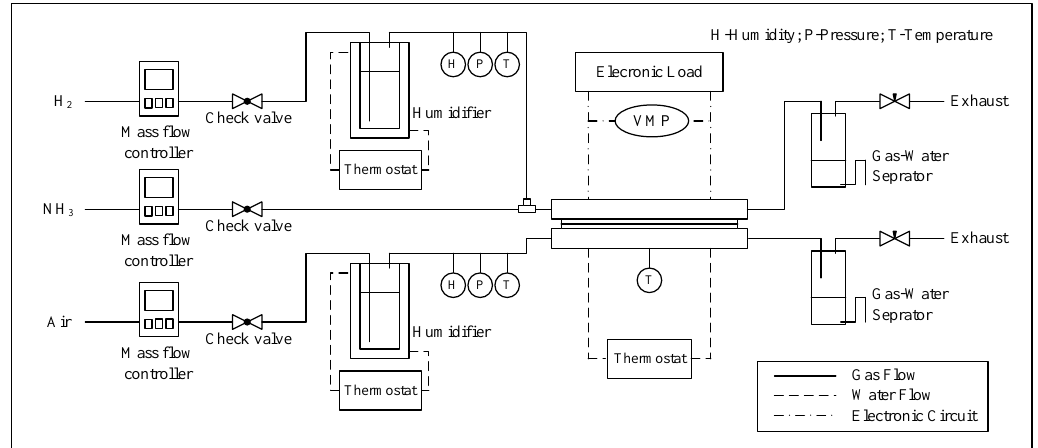
Figure 1. Schematic of PEM fuel cell test bench.